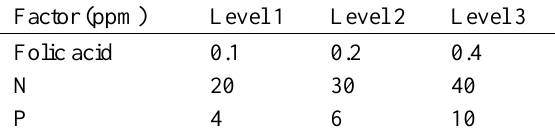
Table 1. Factors and levels exerted in